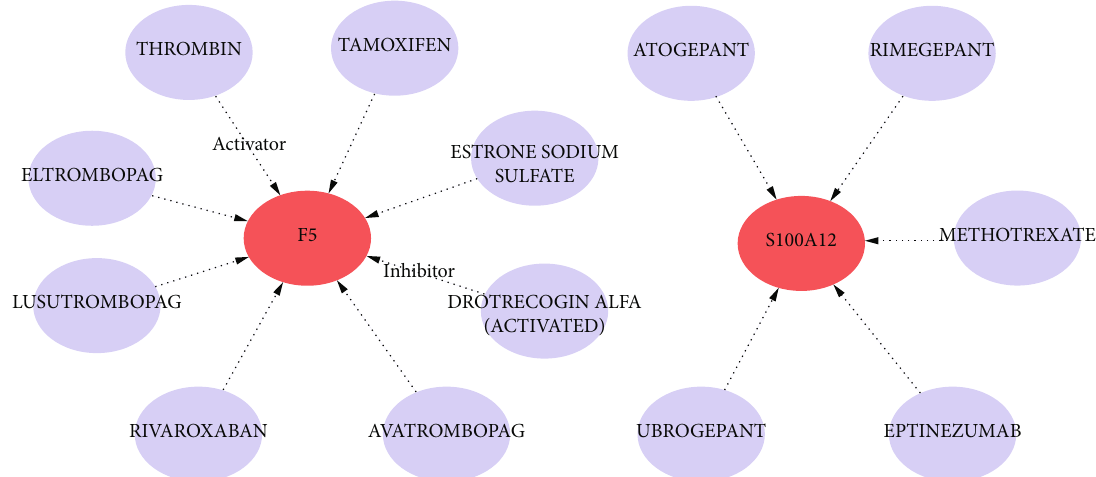
Figure 7: Prediction of targeted drugs or compounds. By DGIdb, 13 drugs or compounds targeting 2 marker genes (F5 and S100A12) were identi fi ed. The drug gene interaction network contained 15 nodes and 13 sides. Red nodes represent genes, and blue nodes represent the drugs or compounds. The lines represent the interaction relationship between the genes and the drugs or